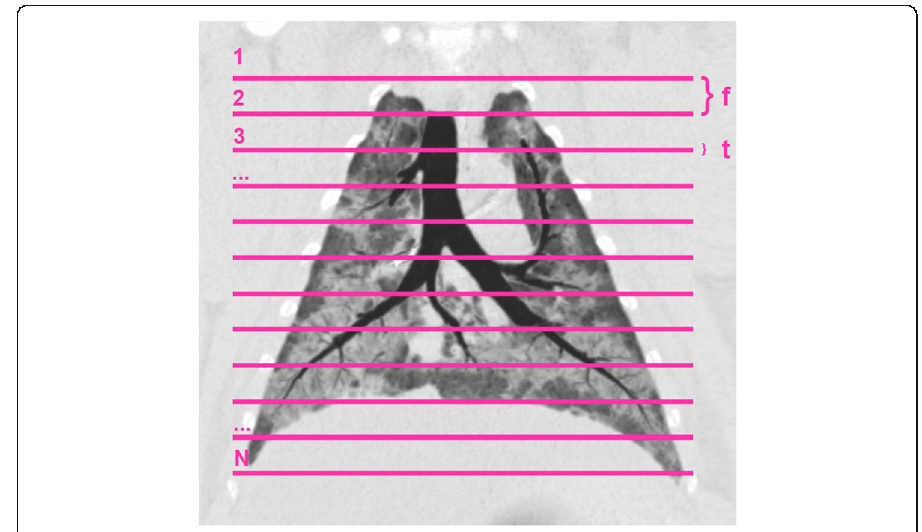
Fig. 1 Coronal plane reconstruction of a representative animal. Lines represent 12 slices acquired with a sequential protocol using 1.0-mm slice thickness ( t ), interleaved by 20 mm feed ( f